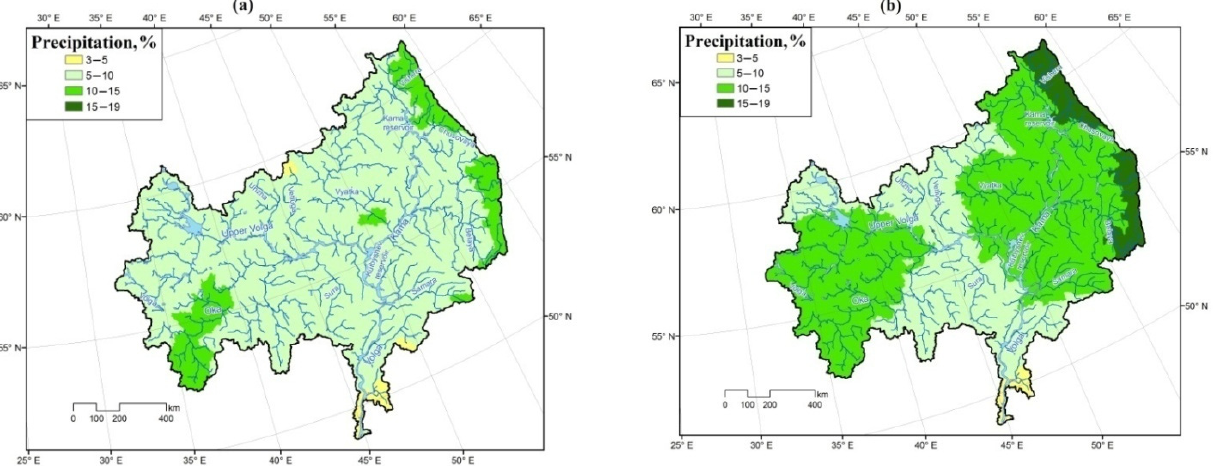
Figure 9. Anomalies of annual precipitation in the Volga basin under global warming by 1.5 °C ( a ) and 2 °C ( b ) in the 21st century relative to the average values of the baseline period 1970–1999.